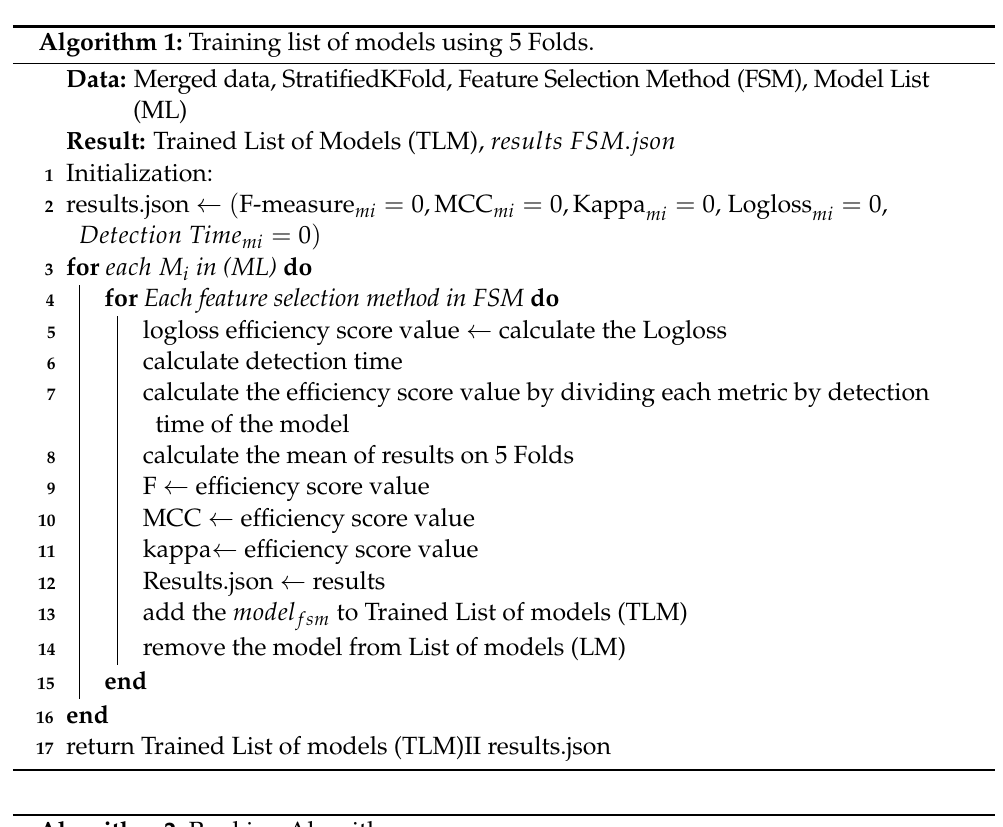
Algorithm 2: Ranking